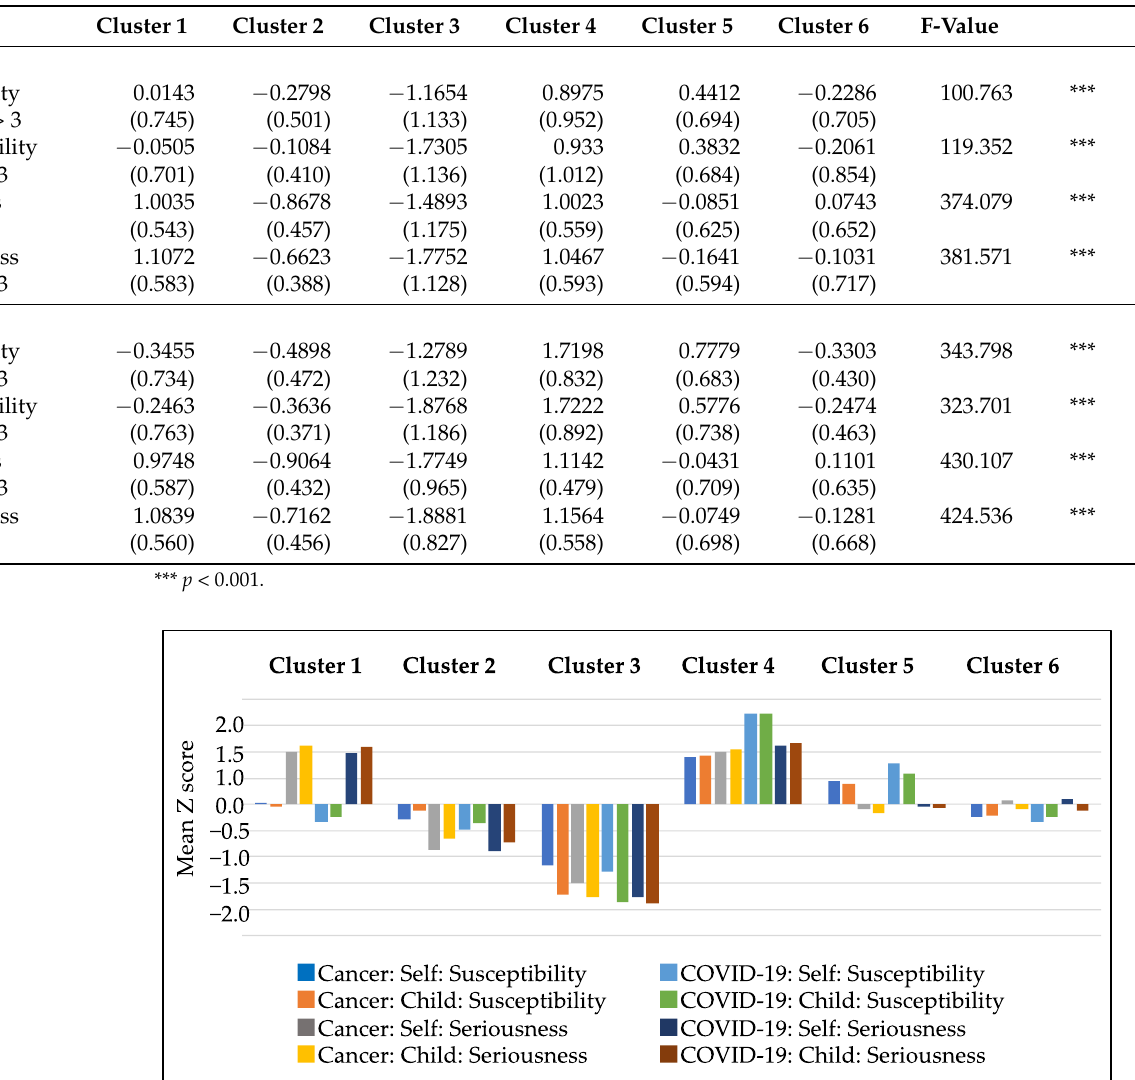
Table 4. Six clusters of cancer and COVID-19 (mean, SD , and multiple comparison for each group).